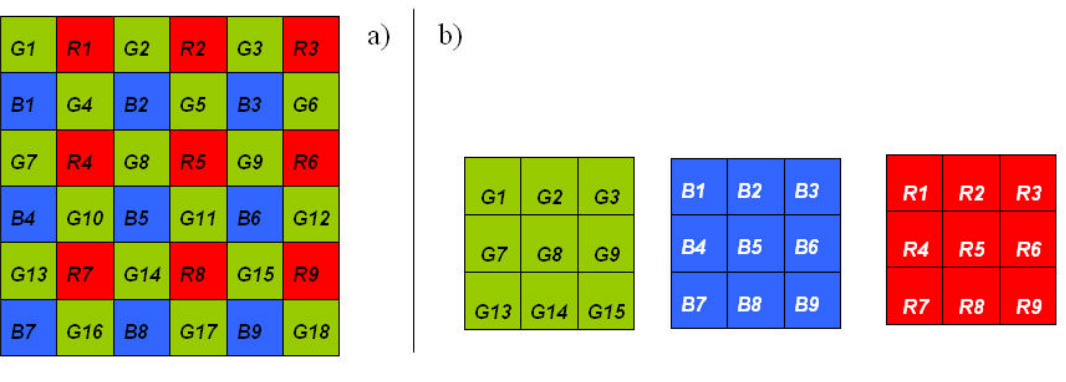
Figure 4. (a) Color Frame Array of the Canon EOS 400D and (b) extraction of “spectrally pure”